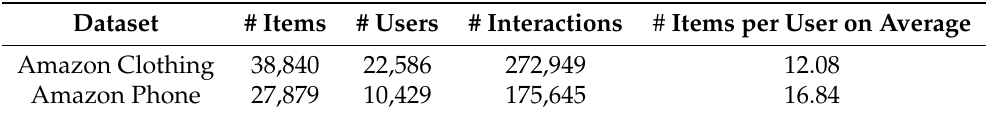
Table 2. The statistics of experimental